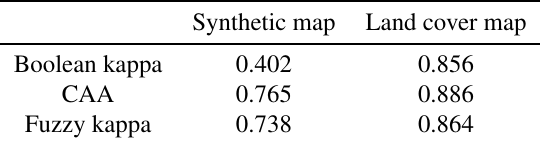
Table 1: Comparison of coefficients of agreement be- tween maps Synthetic